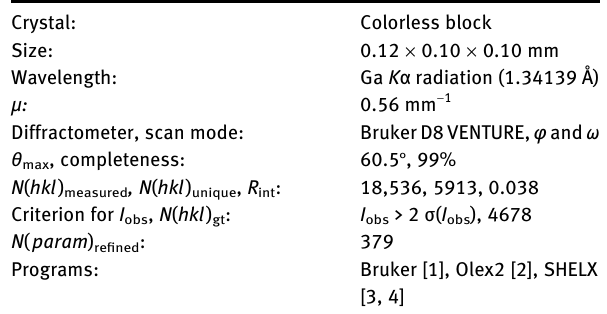
Table  : Data collection and